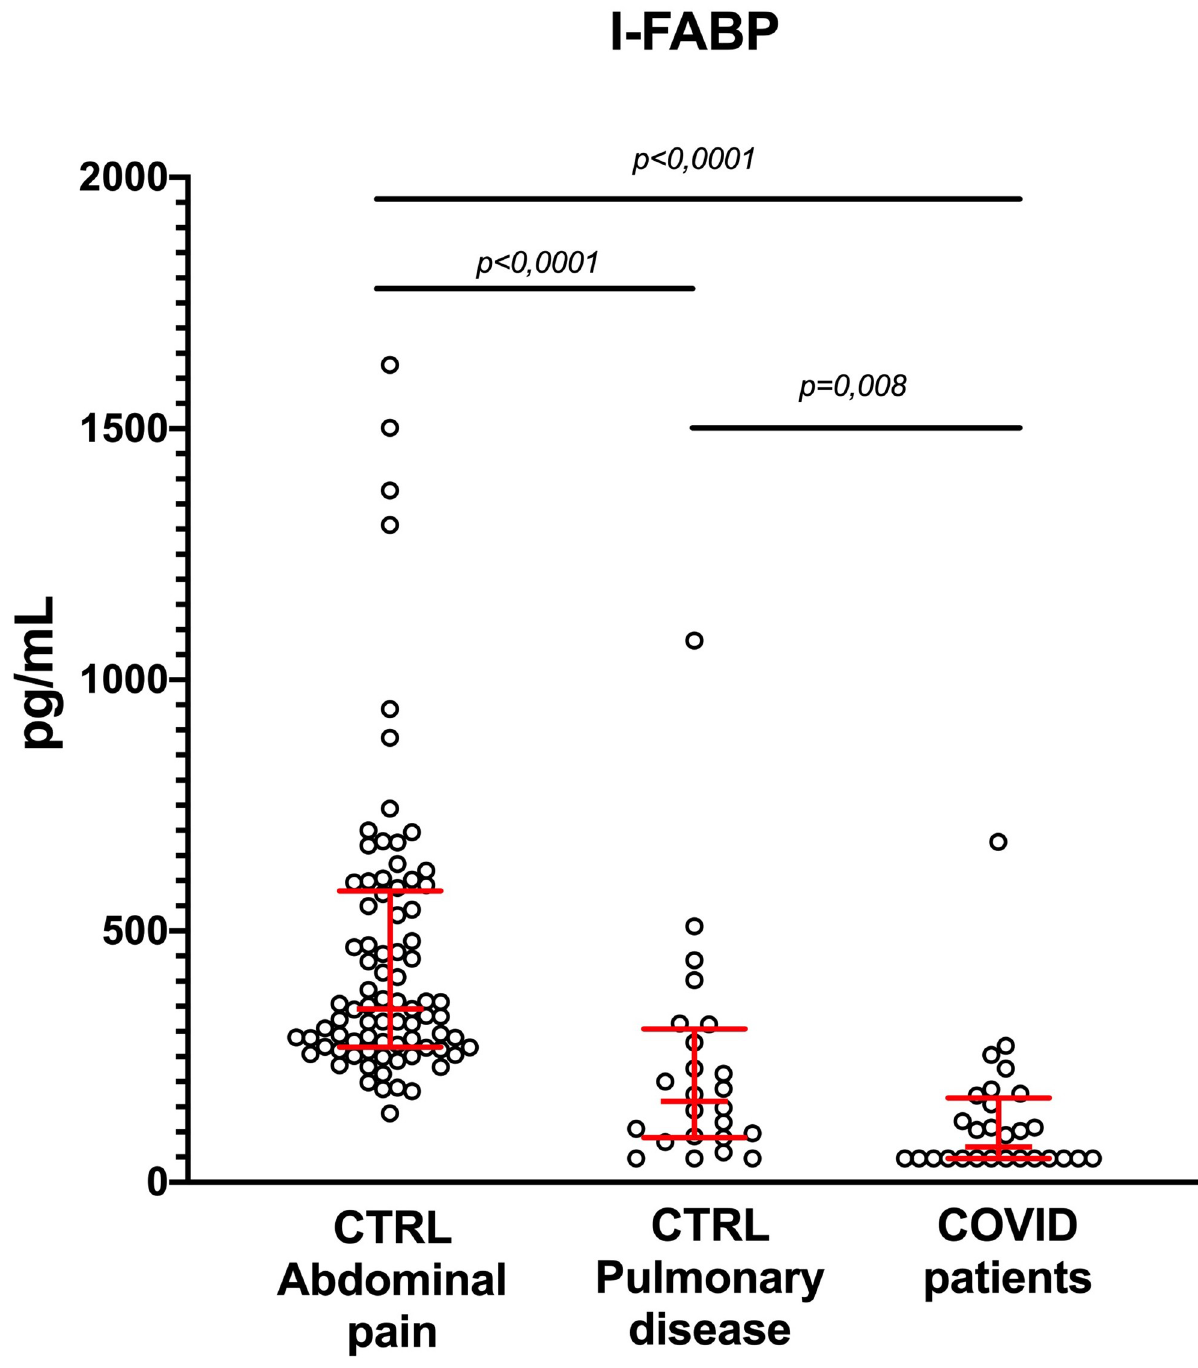
Fig 1. Serum I-FABP concentration is decreased in COVID-19 patients. I-FABP concentrations were measured in COVID-19 patients (n = 28) and in patients with abdominal pain or pulmonary disease (n = 79 and 24, respectively). ANOVA and Mann-Whitney tests were used for statistical comparison. CRTL: